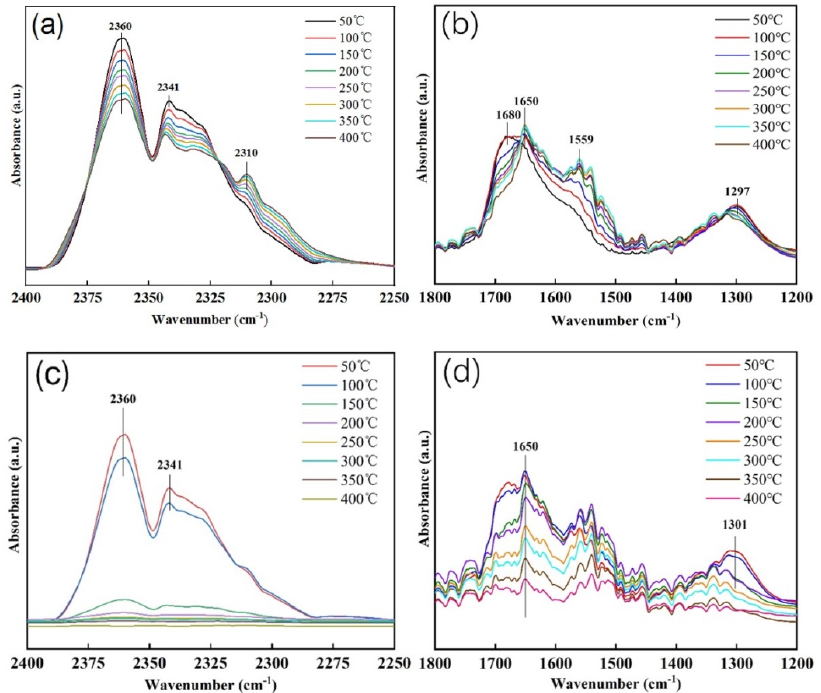
Figure 4. In-suit DRIFT spectra of SrTiO 3 support under CO 2 and H 2 co-adsorption ( a , b ); and pre-adsorption of CO 2 and then under H 2 purging ( c , d ).